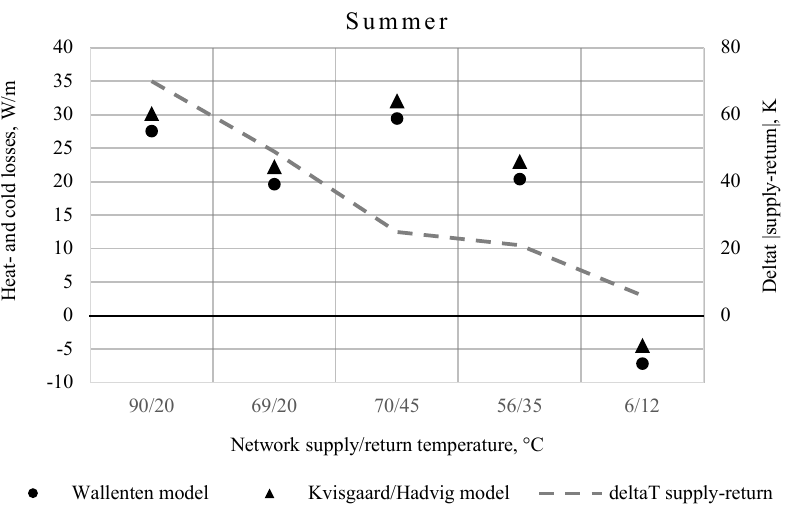
Fig. 4. Calculated heat and cold losses – summer case.